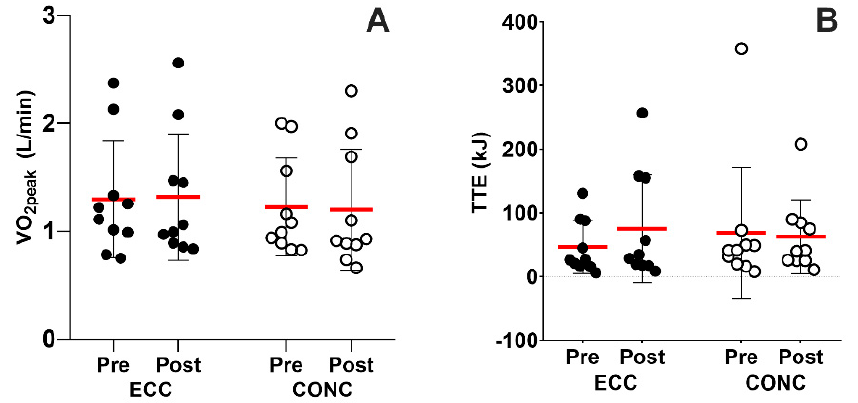
Figure 1. Maximal and submaximal aerobic performance. Peak oxygen consumption during the incremental cycling test ( A ) and workload performed in the time to exhaustion test ( B ). ECC: eccentric cycling, CONC: concentric cycling.